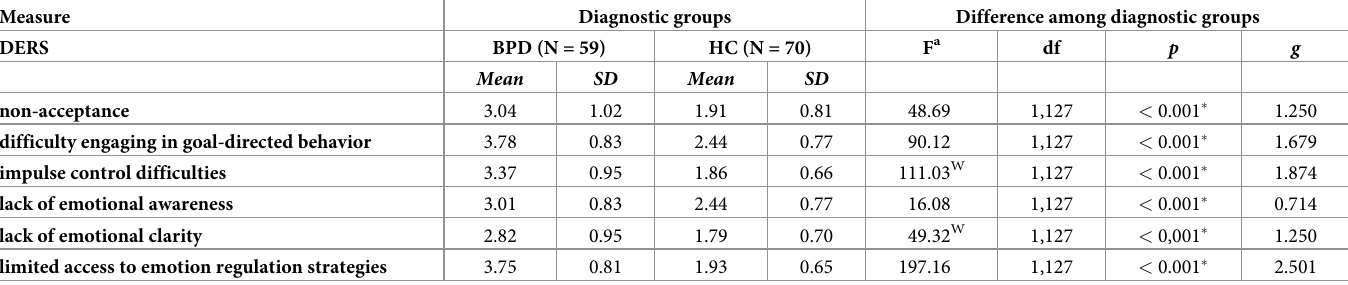
Table 4. Group comparisons for the BPD and HC groups on the subscale scores of the difficulties of emotion regulation scale, and effect sizes measured by Hedge’s g formula. Measure Diagnostic groups Difference among diagnostic